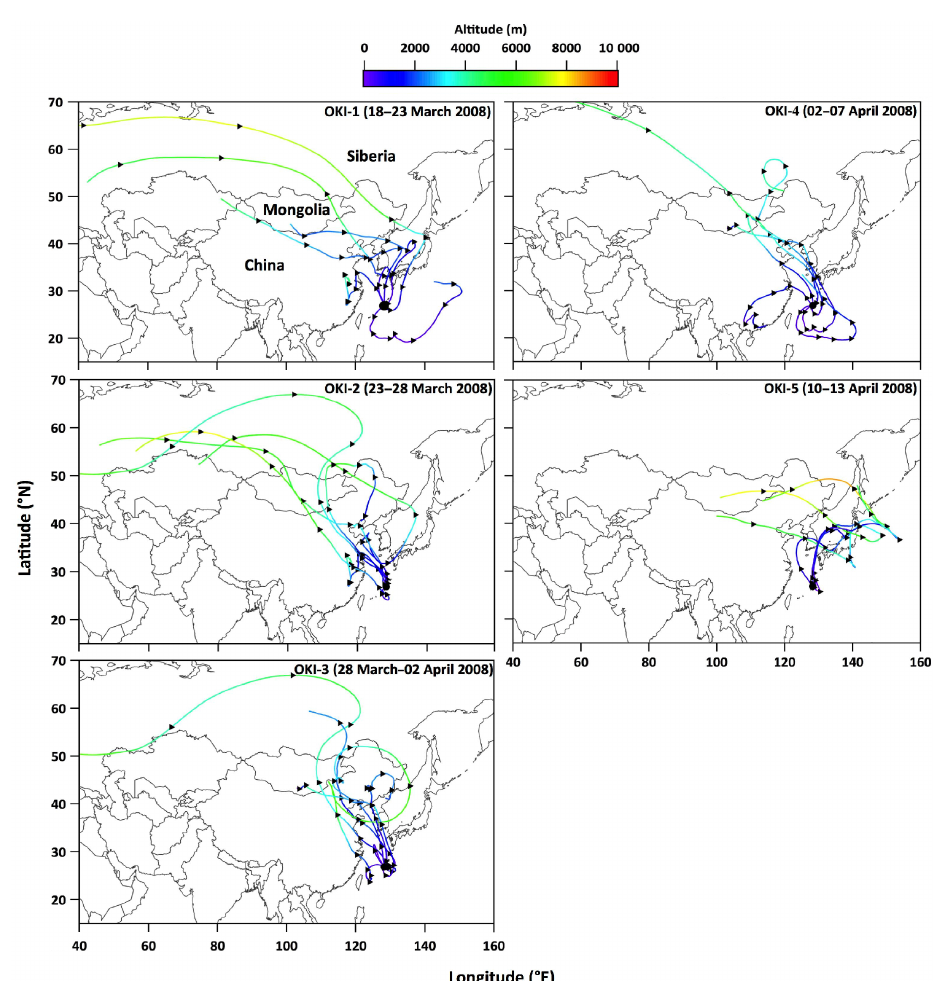
Figure 2. Seven-day backward air mass trajectories (NOAA HYSPLIT) at 500ma.g.l. (09:00UTC) for the aerosol samples (OKI-1 to OKI- 5) collected on Okinawa Island. The dates given in each panel are the starting and ending times of the collection of aerosol samples on Okinawa Island. The color scale shows the altitude of the air